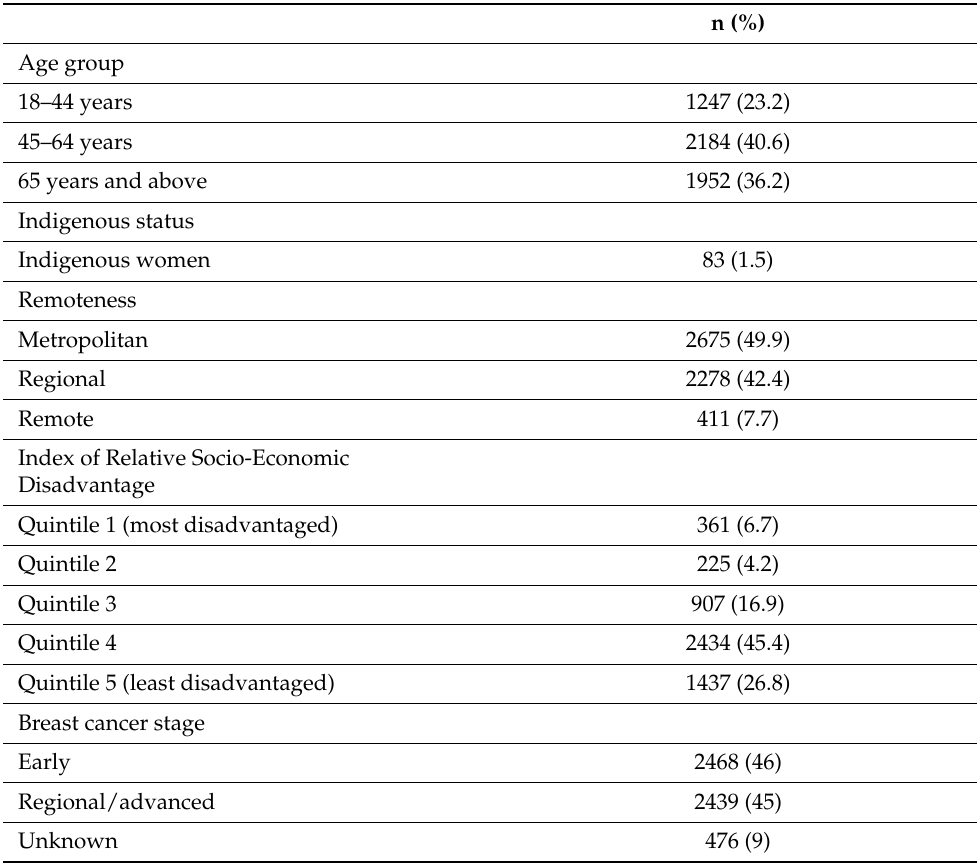
Table 1. Demographic characteristics at diagnosis of Queensland women with breast cancer diag- nosed between 1 July 2011 and 30 June